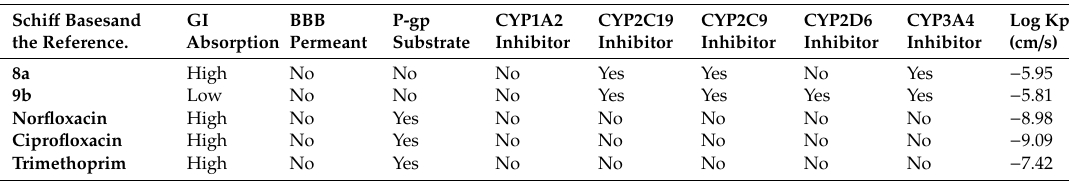
Table 11. In silico the pharmacokinetics properties of the two pyrazole Schi ff bases ( 8a and 9b ) and the reference